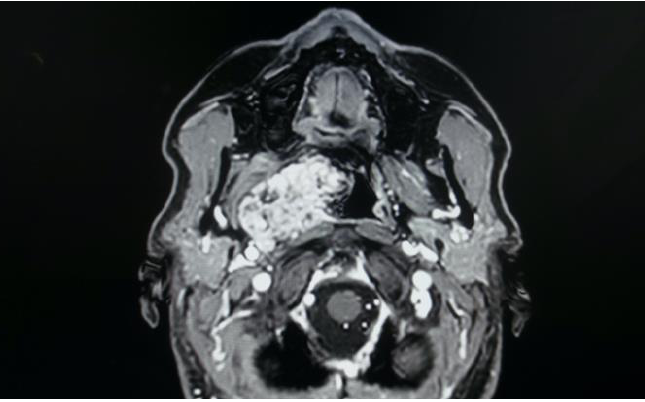
Figure 7. Pleomorphic adenoma of the true PPS originating from extraparotid salivary tissue.